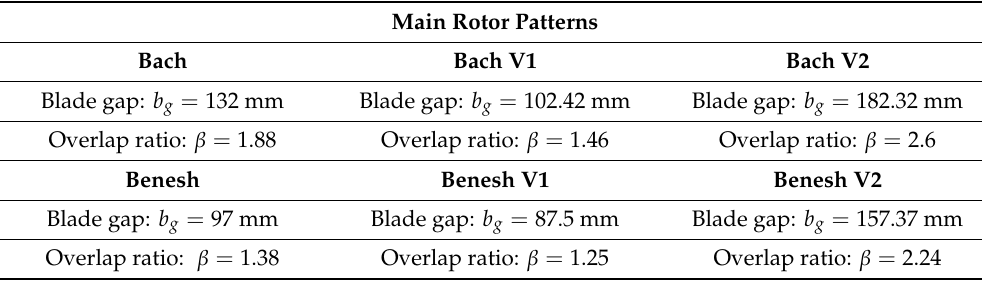
Table 3. Blade gap and overlap ratio for main rotor types considered for